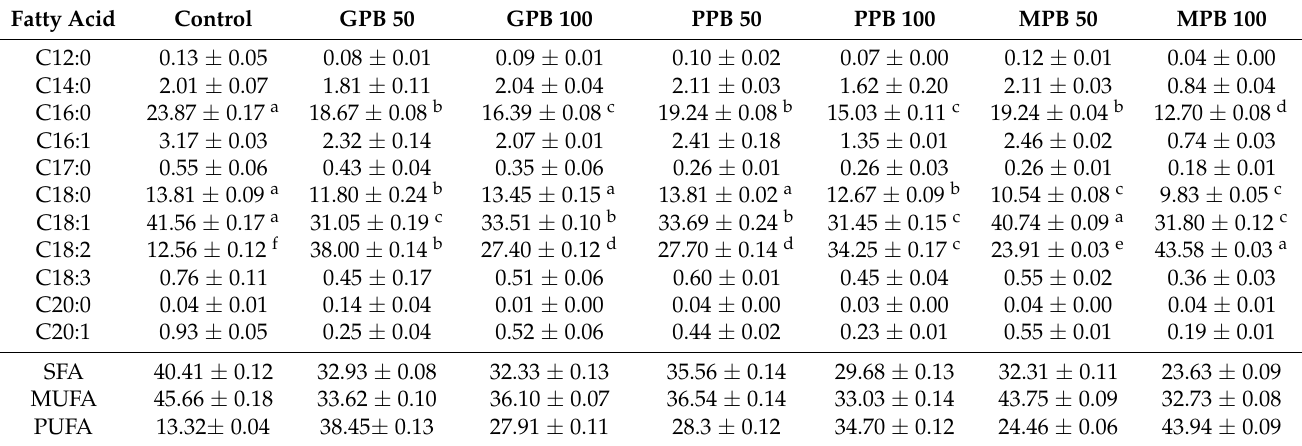
Table 7. Fatty acid composition of the burgers reformulated with pumpkin seed